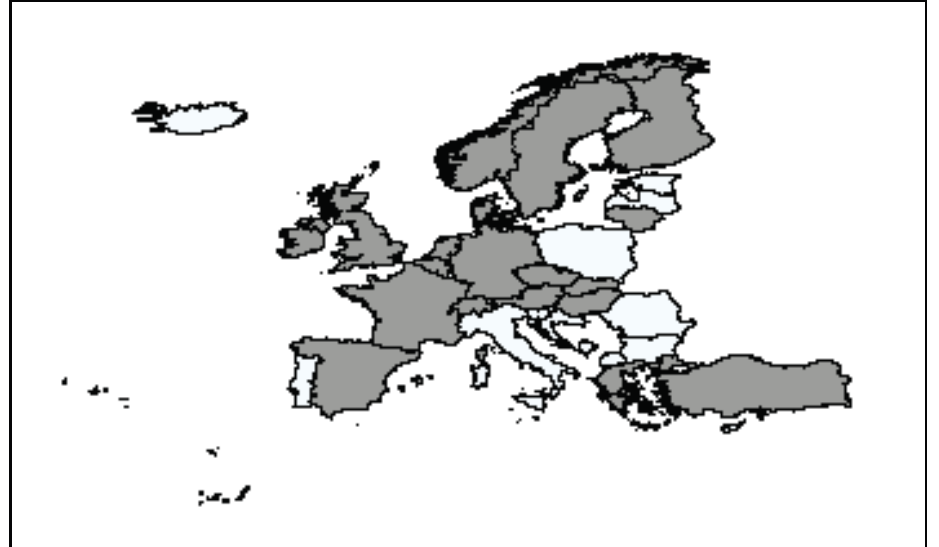
Figure 1. Map of European countries included in the